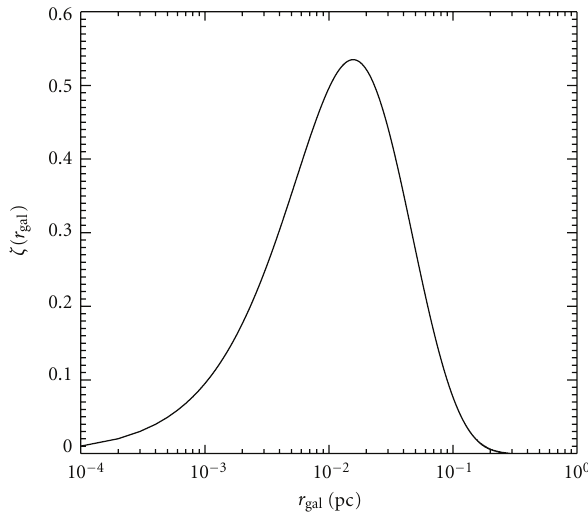
Figure 12: The fraction of flux emitted from unbound material at radius r gal that contributes to the 2–10keV